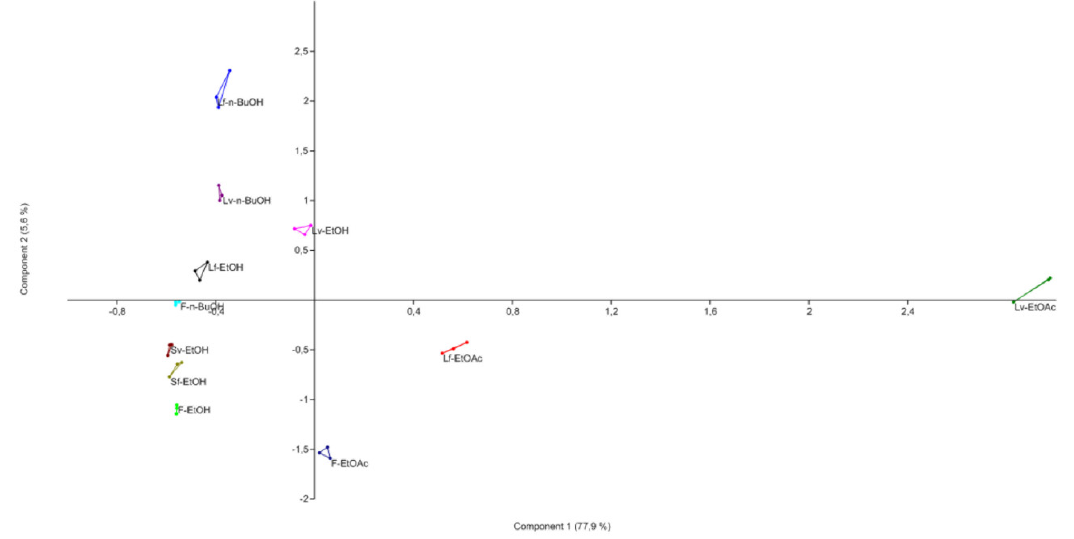
Figure 2. Scatter plot of PCA of the extracts on the first two principle components.